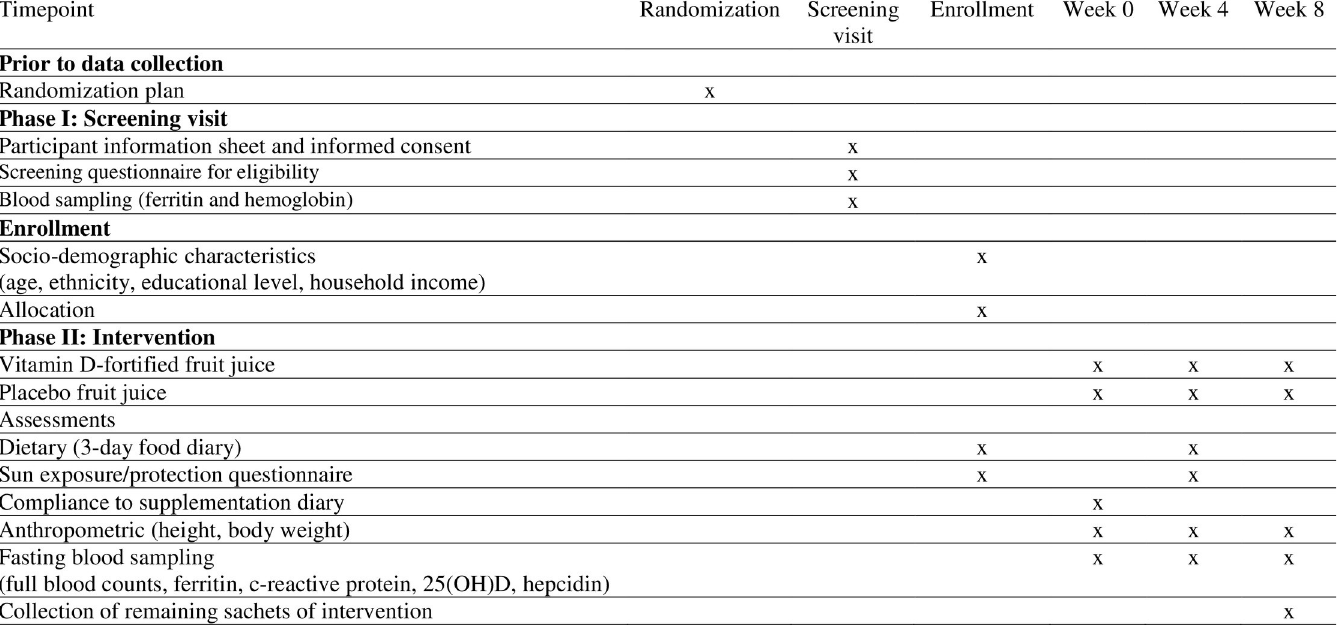
Fig 1. Timepoint of study enrollment, interventions and